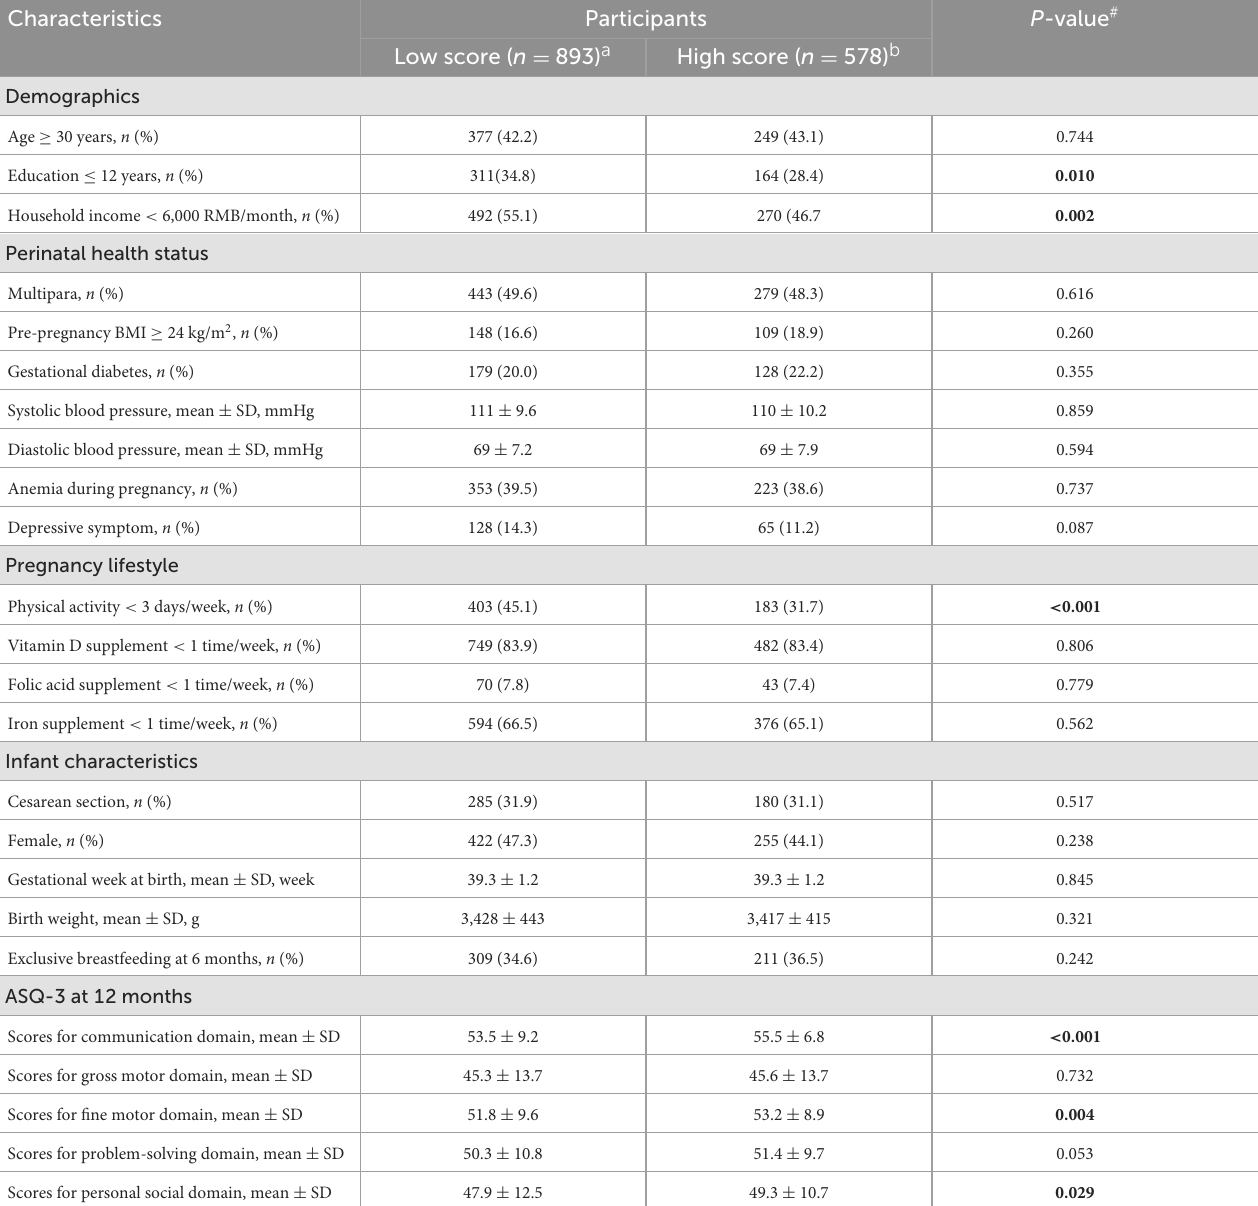
TABLE 1 Characteristics of mothers and